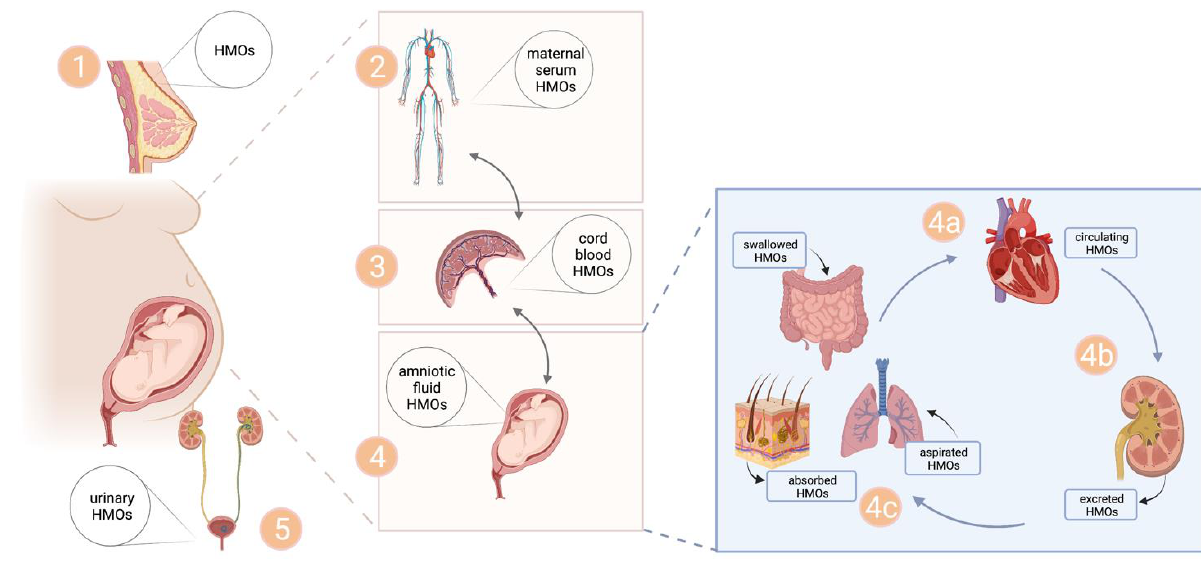
Figure 4. Scheme of the proposed pathway of HMOs in pregnancy. HMOs are produced in the mammary gland (1) during pregnancy, reach the maternal circulation (2) and might cross the placental barrier to reach the cord blood (3) and the amniotic fluid (4), before they are excreted via maternal urine (5). HMOs enter fetal circulation via the umbilical vein, and might either cycle back to the placenta via the umbilical artery or be excreted via fetal urine to reach amniotic fluid (AF) (4a–4c). AF HMOs are swallowed and come in extensive contact with gastrointestinal tract mucosal lining, where they are partly absorbed into fetal blood (4a) and are excreted via urine (4b). HMOs in AF might potentially be absorbed by fetal skin and might also come into contact with lungs via fetal aspiration of AF. Created with BioRender.com.